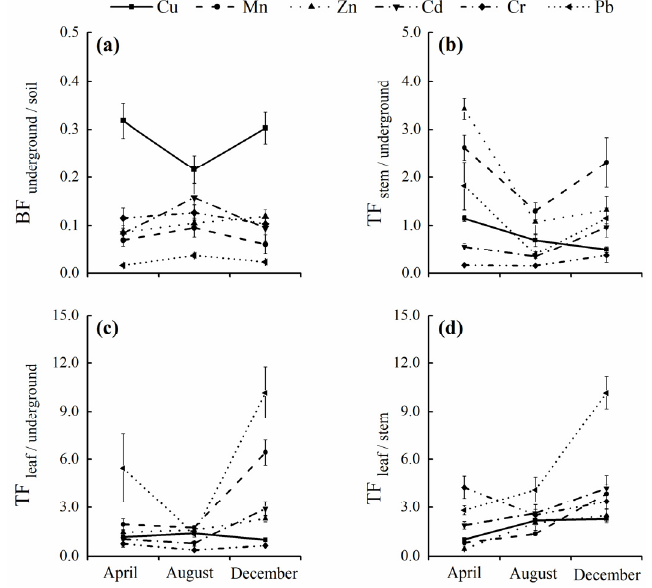
Figure 3. The bioaccumulation factor (BF) and translocation factor (TF) in the different parts (un- derground organs, stems and leaves) of Miscanthus lutarioriparius for Cu, Mn, Zn, Cd, Cr and Pb across different sampling time. Bars indicate standard errors of means.